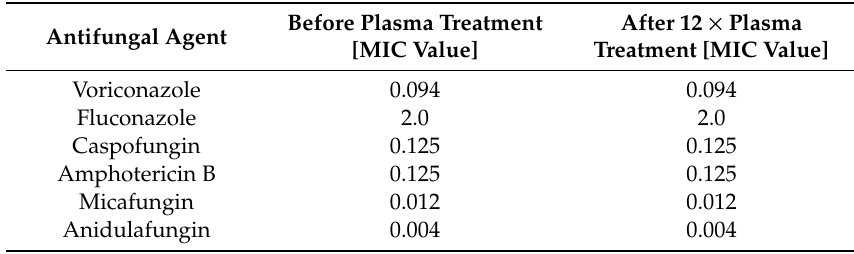
Table 4. Minimum inhibitory concentration (MIC) values ( µ g / mL) of antifungal agents for the investigated C. albicans